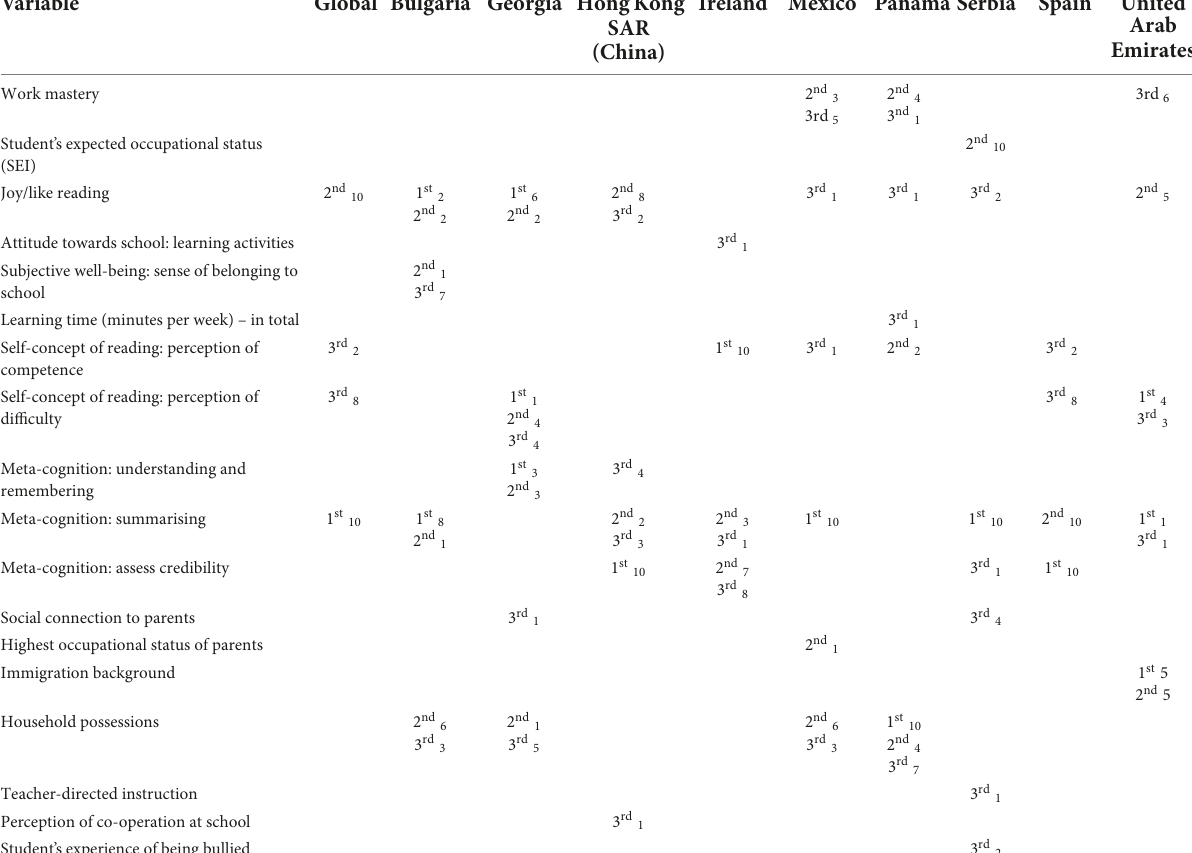
TABLE 4 Variables that best describe the profile of students with the lowest academic achievement in reading literacy. Variable